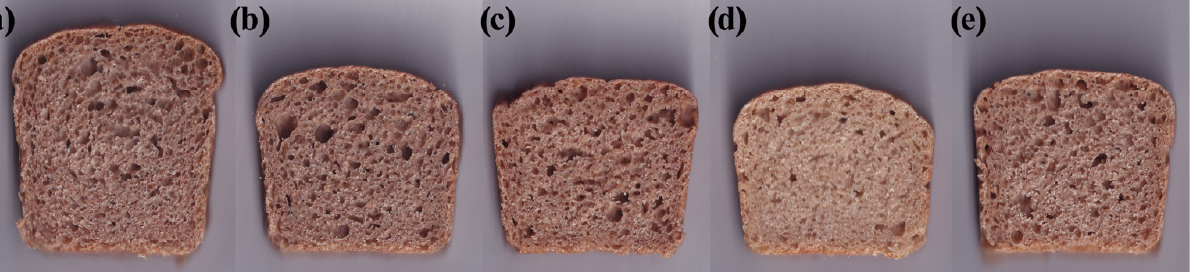
Figure 3. Bread crumb appearance of ( a ) control (yeast fermented), ( b ) wheat, ( c ) emmer, ( d ) khorasan and ( e ) spelt sourdough bread.